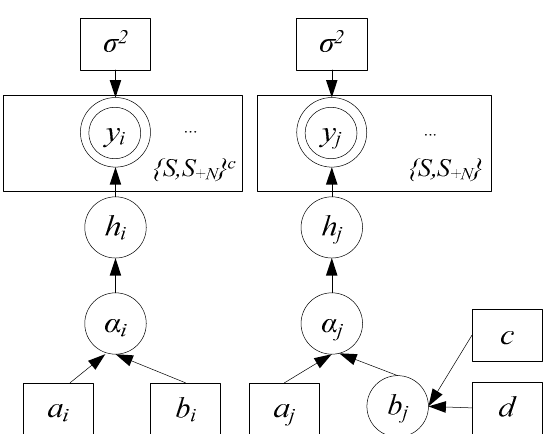
Figure 1. Graphical model for the channel estimation with Bayesian inference. The nodes with double circle, single circle and square correspond to the observed data, hidden variables and parameters, respectively.